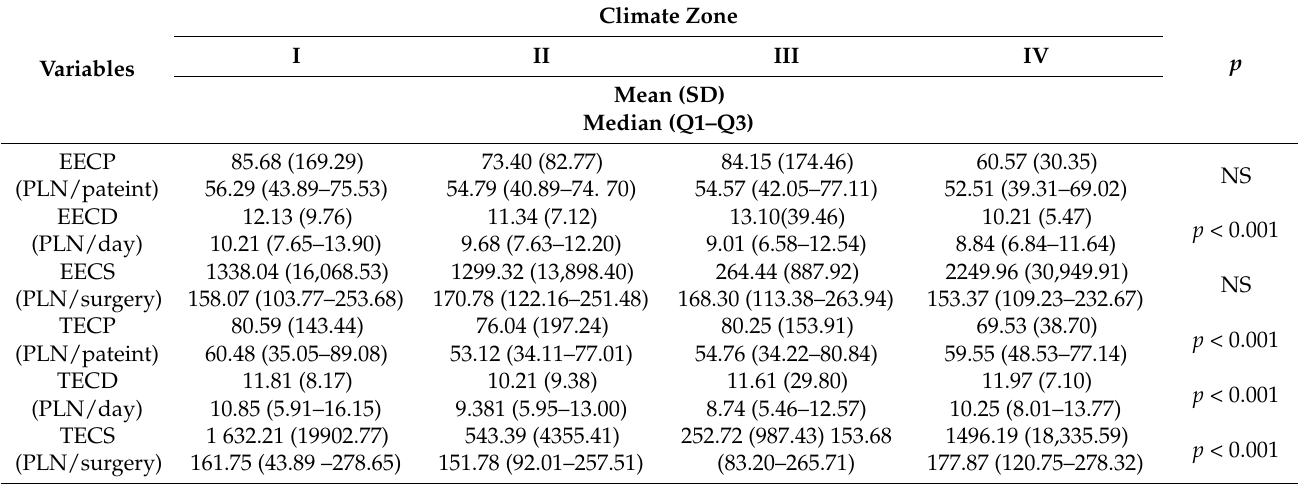
Table 7. Electrical and thermal energy unit costs according to climate zones in